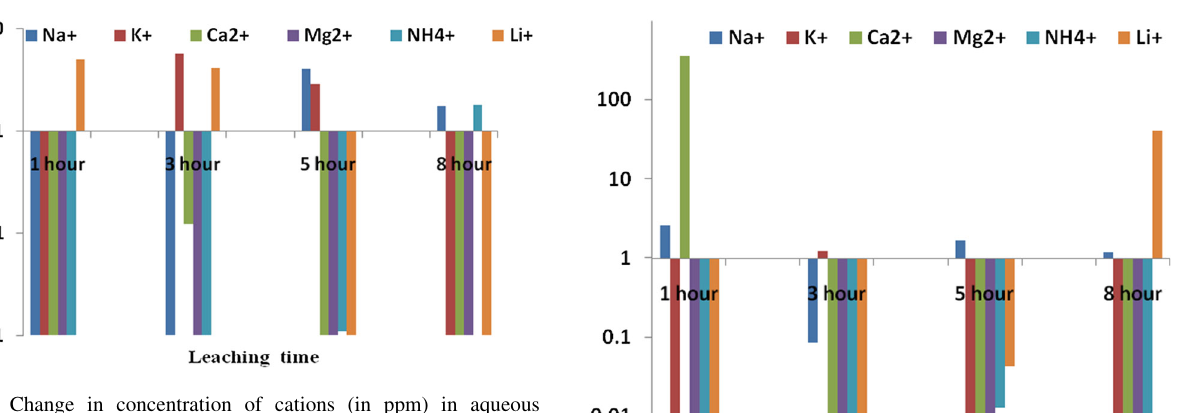
Fig. 7 Change in concentration of cations (in ppm) in aqueous leachates of Ledo coal (LC-20A) with leaching time (in hour) at 45 (cid:3) C